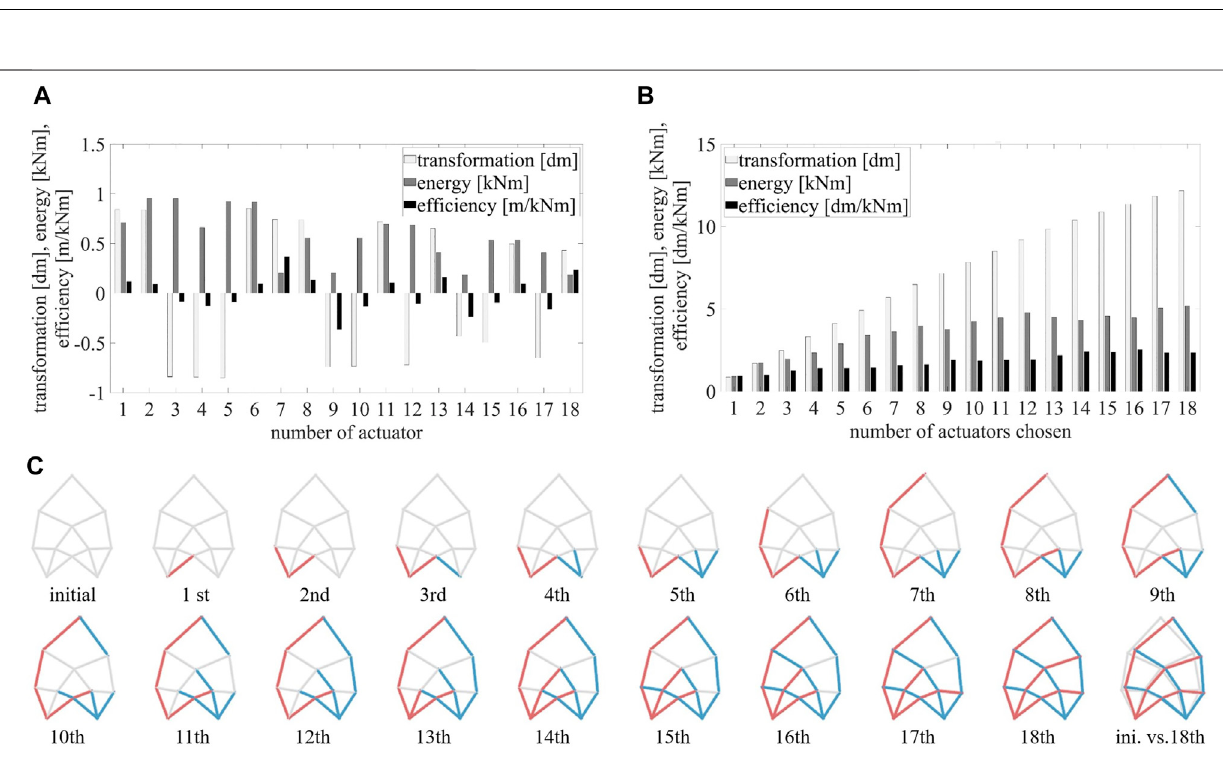
FIGURE 4 | Michell truss approximation according to Wiedemann (1996) as basis structure for validation of operator χ , (A) design space and loading, (B) approximation of trajectory lines and shape determining single load, (C) Michell truss and transformation direction u , and (D) corresponding numbers of individual actuator analysis ( Figure 5A